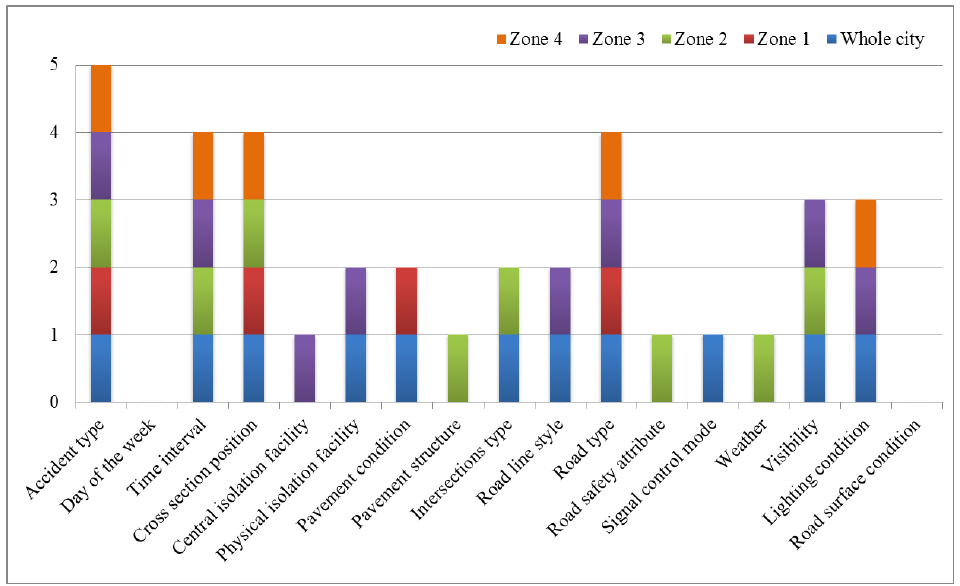
Figure 1. The statistical results of Pearson’s chi-squared test. Table 6. Binary logistic regression